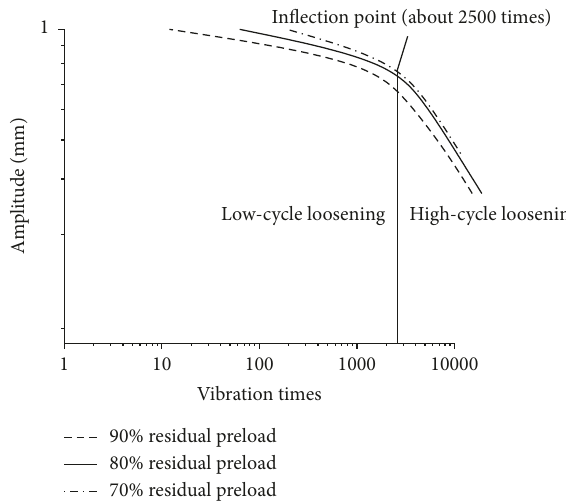
Figure 8: Low-cycle loosening and high-cycle loosening of the loosening D-N curve.